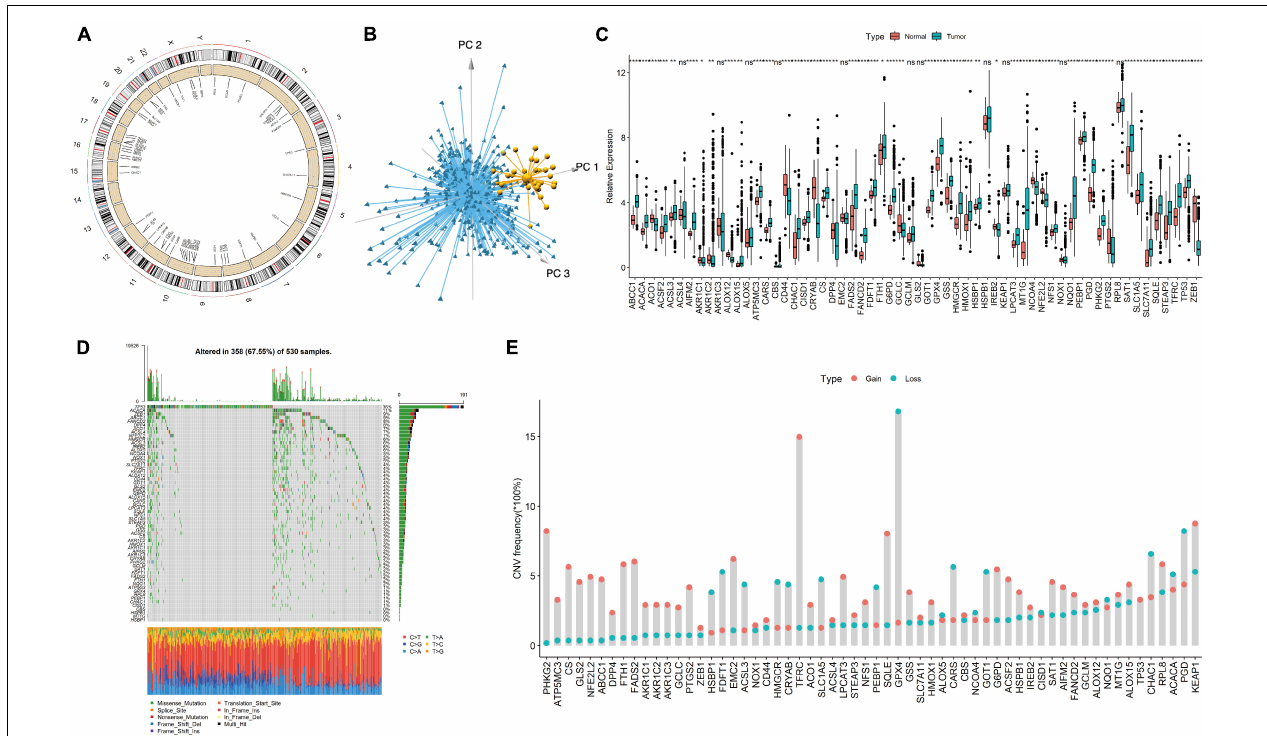
FIGURE 1 | Display of ferroptosis genes in endometrial cancer (EC) samples. (A) The genomic positions of 60 ferroptosis genes. (B) Principal component analysis of 60 ferroptosis genes in tumor and normal samples. Blue, EC samples; yellow, normal samples. (C) The expression differences of 60 ferroptosis genes between tumor tissues and normal tissues. (D) Somatic mutation spectrum of ferroptosis genes in EC samples. (E) CNV mutation frequency of 60 ferroptosis genes in EC samples. Ns, p > 0.05; * p < 0.05; ** p < 0.01; *** p < 0.001; **** p <